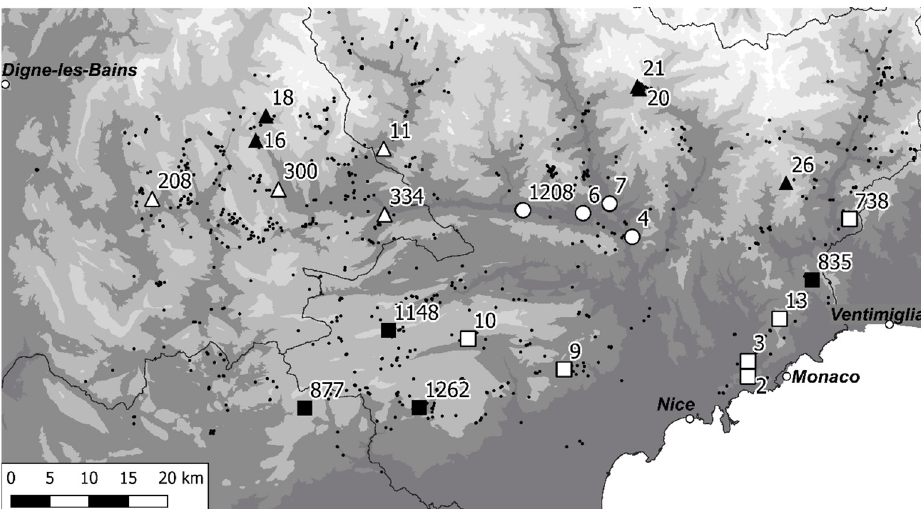
Figure 1. Location of the sampled sites (large symbols) in the distribution of Lilium pomponium (small black circles). Open circles—low-altitude stations, open squares—mid-altitude Mediterranean, open triangles—mid-altitude temperate mountain, black squares—high-altitude Mediterranean, black triangles—high-altitude temperate mountain. Black lines are the limits of French departments.